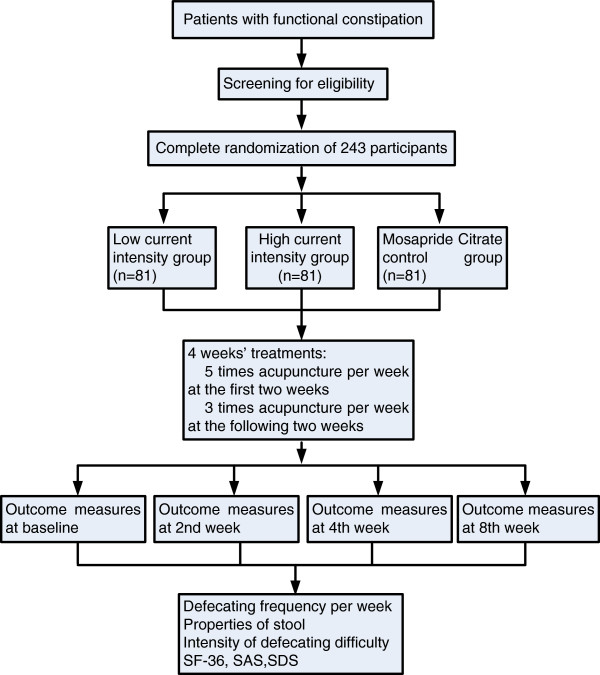
Trial flow chart.